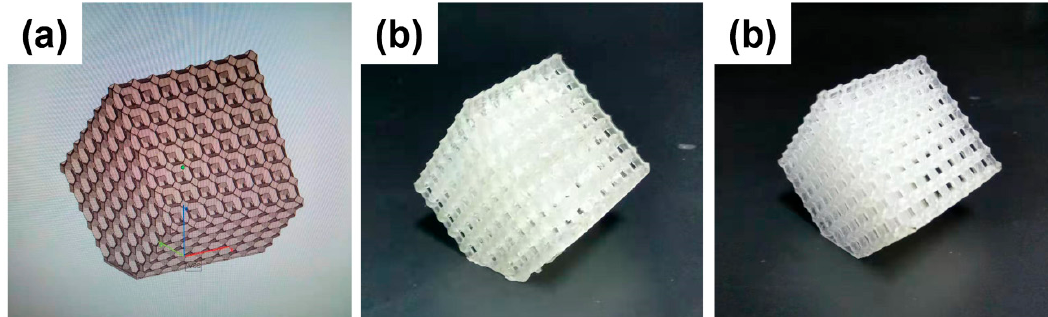
Figure 16. ( a ) 3D model designed by computer-aided design (CAD) software, ( b ) and ( c ) are 3D printed objects using neat SLR and R/ANT800 composite samples by SLA 3D printer apparatus, respectively.